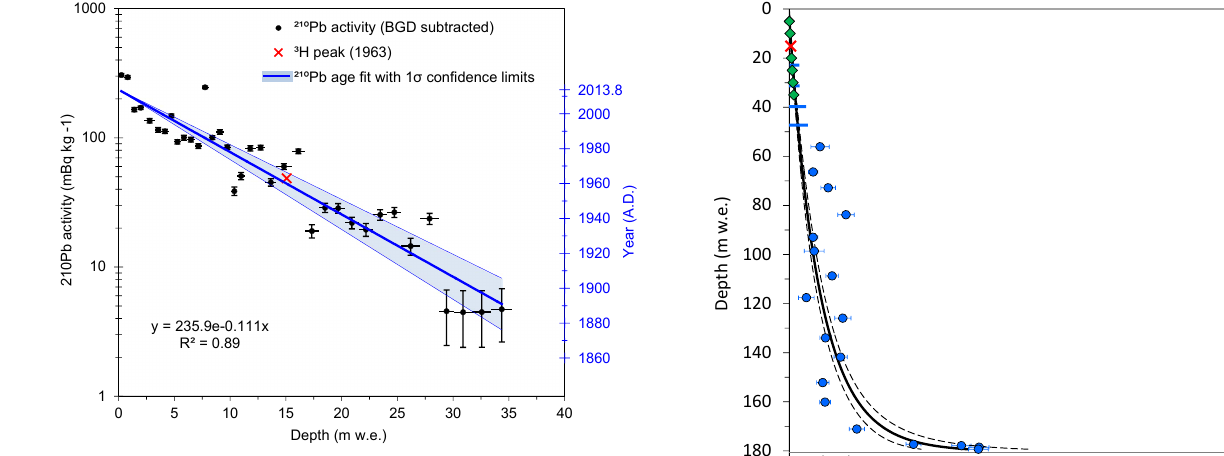
Figure 3. 210 Pb activity profile of the Chongce 216.6m Core 4 and the derived age–depth relationship. The 3 H fallout horizon indicat- ing the year 1963 is located within the uncertainty of the 210 Pb results. Please note that the 1 σ confidence band is related to the right-hand y axis only.